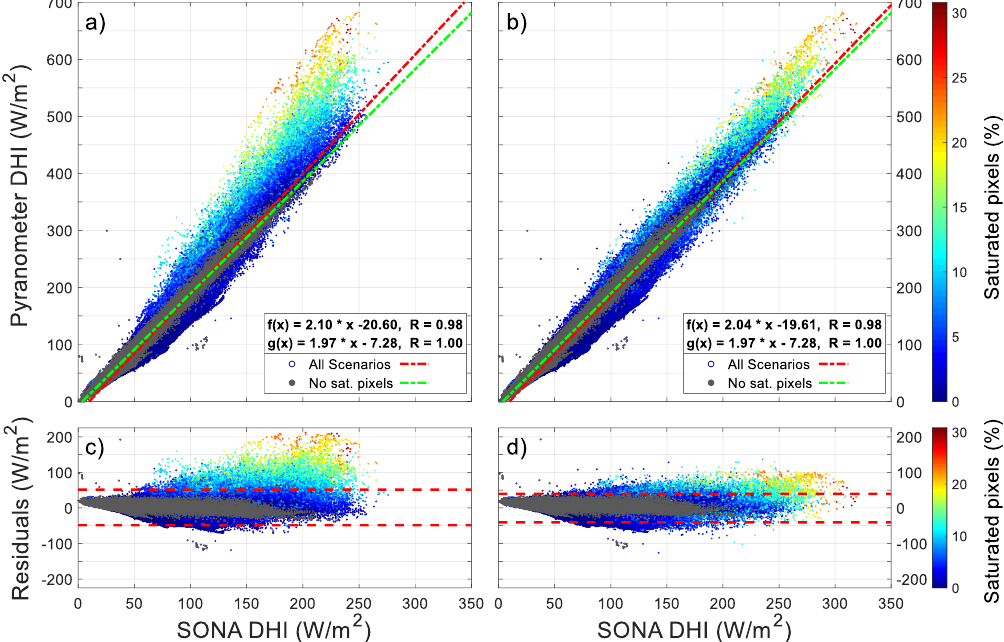
Figure 11. Comparison of pyranometer DHI vs. SONA-DHI from 12 February 2020 to 26 March 2021: ( a ) scatter plot, not considering saturated pixels; ( b ) scatter plot including saturated pixels; ( c ) residuals, not considering saturated pixels; and ( d ) residuals including the saturated pixels. The color bar accounts for the percentage of saturated pixels in each image, while the grey color represents the images with no saturated pixels. f(x) is the fit function for all images, represented by the red colored line, and g(x) is the fit line using only images without saturated pixels, represented by the green colored line. Two red dashed lines represent the 95% confidence interval of the residuals. Note that the residual is defined as the pyranometer DHI minus SONA DHI.